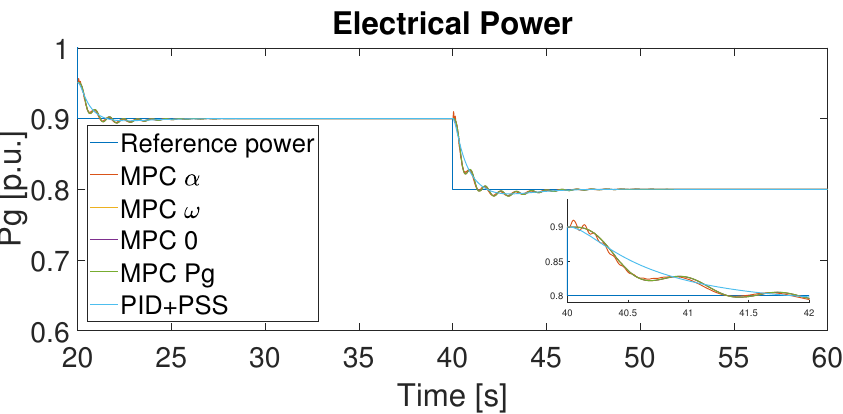
Figure 11. Electric power (set active power